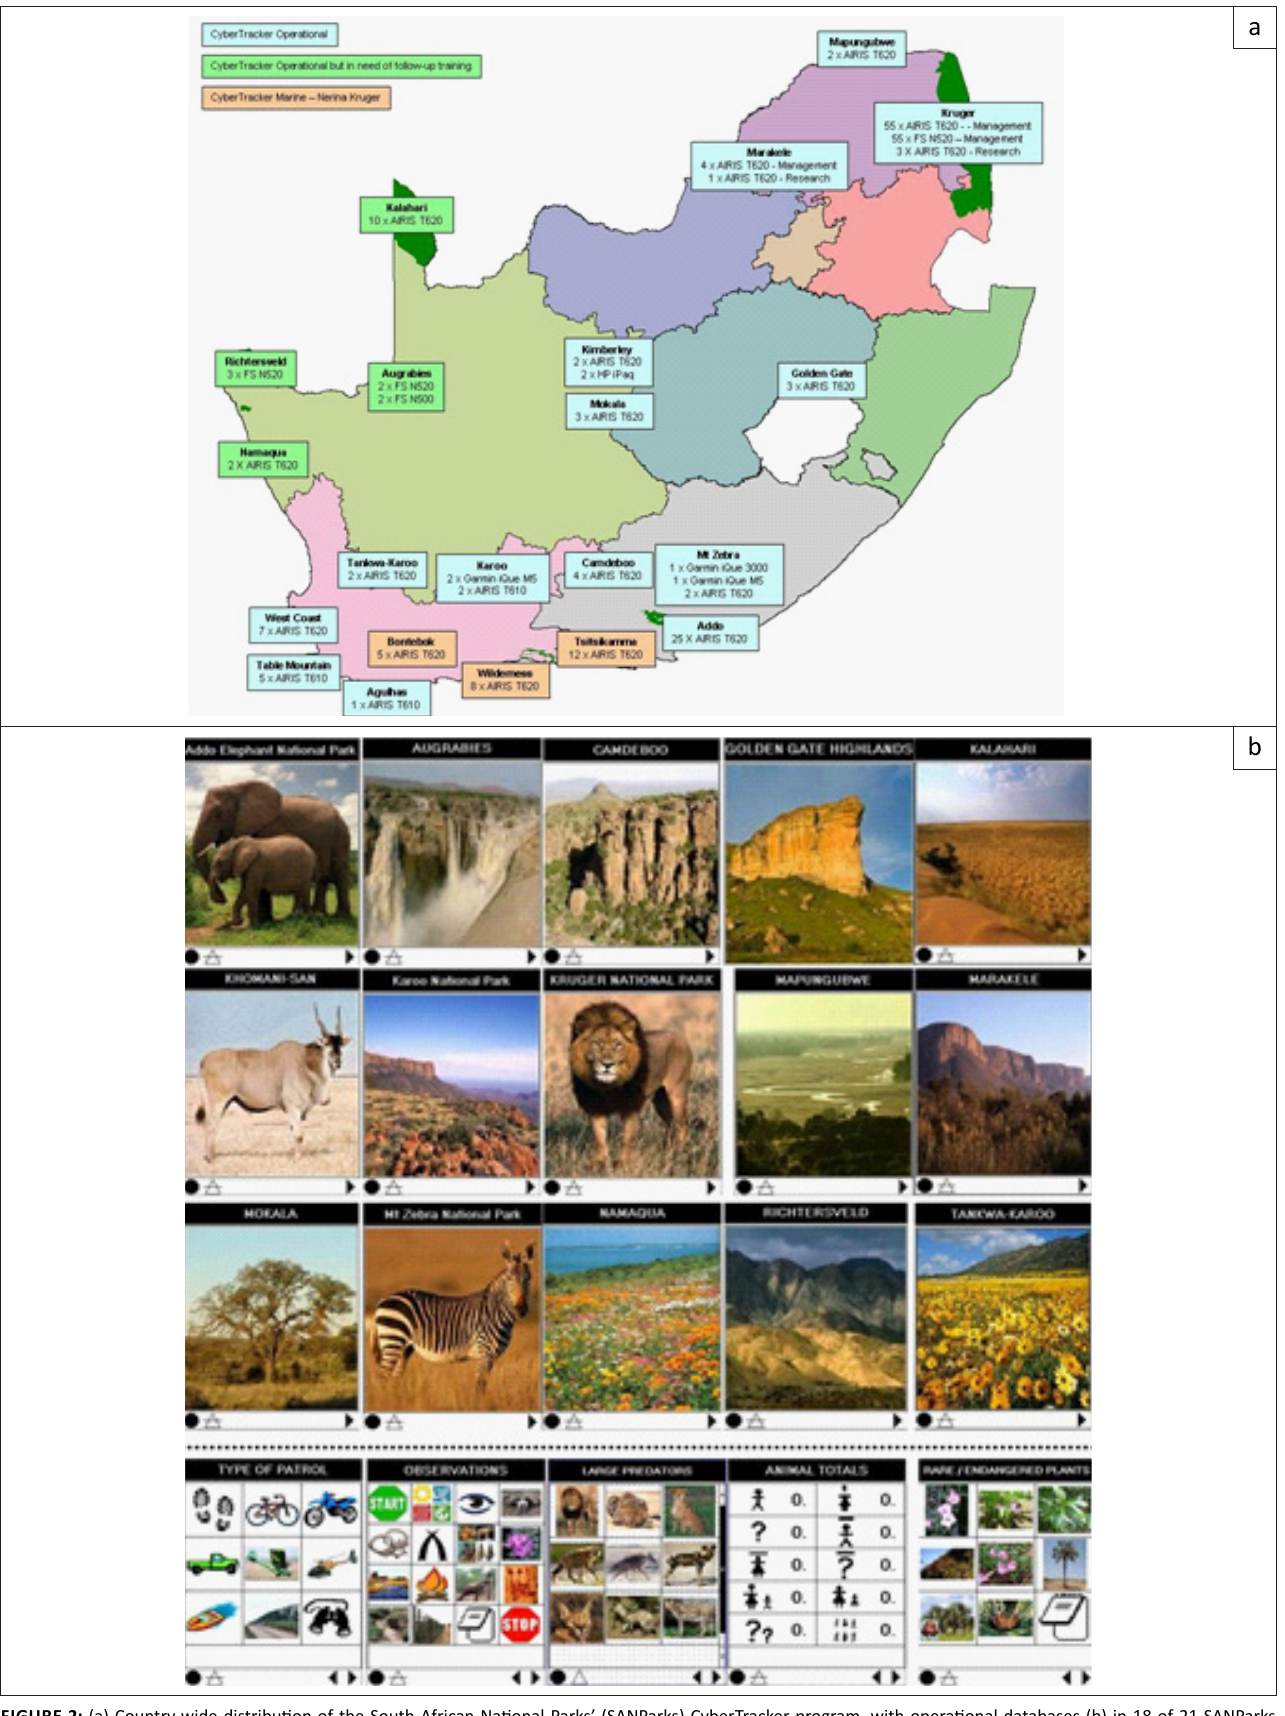
FIGURE 2: (a) Country-wide distribution of the South African National Parks’ (SANParks) CyberTracker program, with operational databases (b) in 18 of 21 SANParks customised to facilitate conservation management, research and